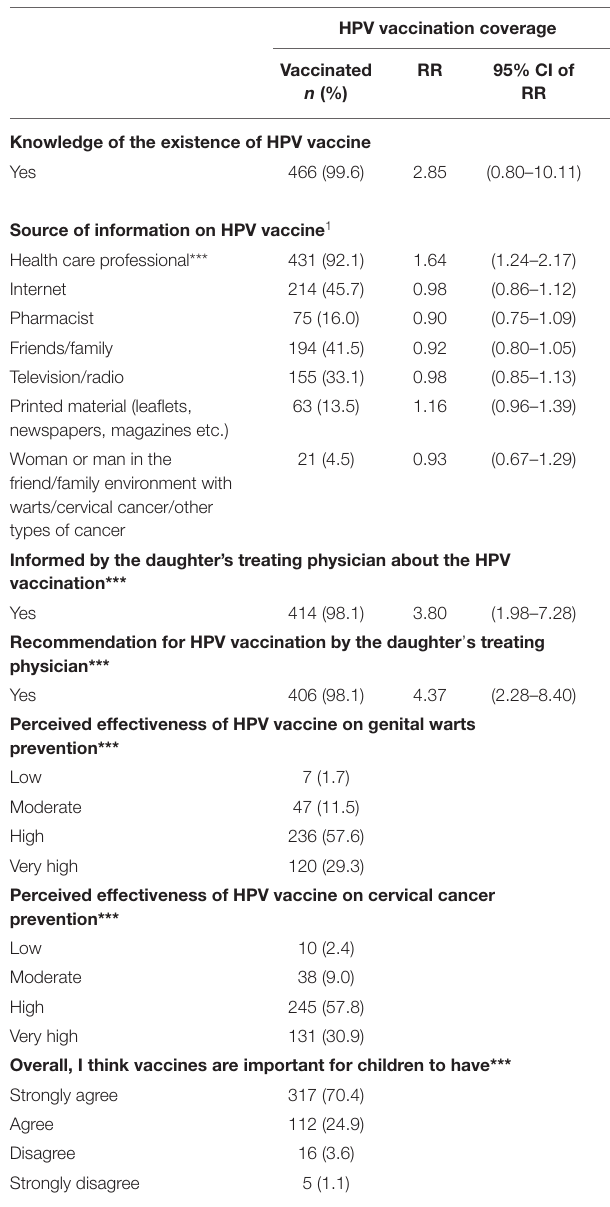
TABLE 4 | Parents’ knowledge and attitudes about HPV vaccination, and univariate associations with vaccination coverage of their daughter aged 11–18 years (incl. Risk Ratio and 95%